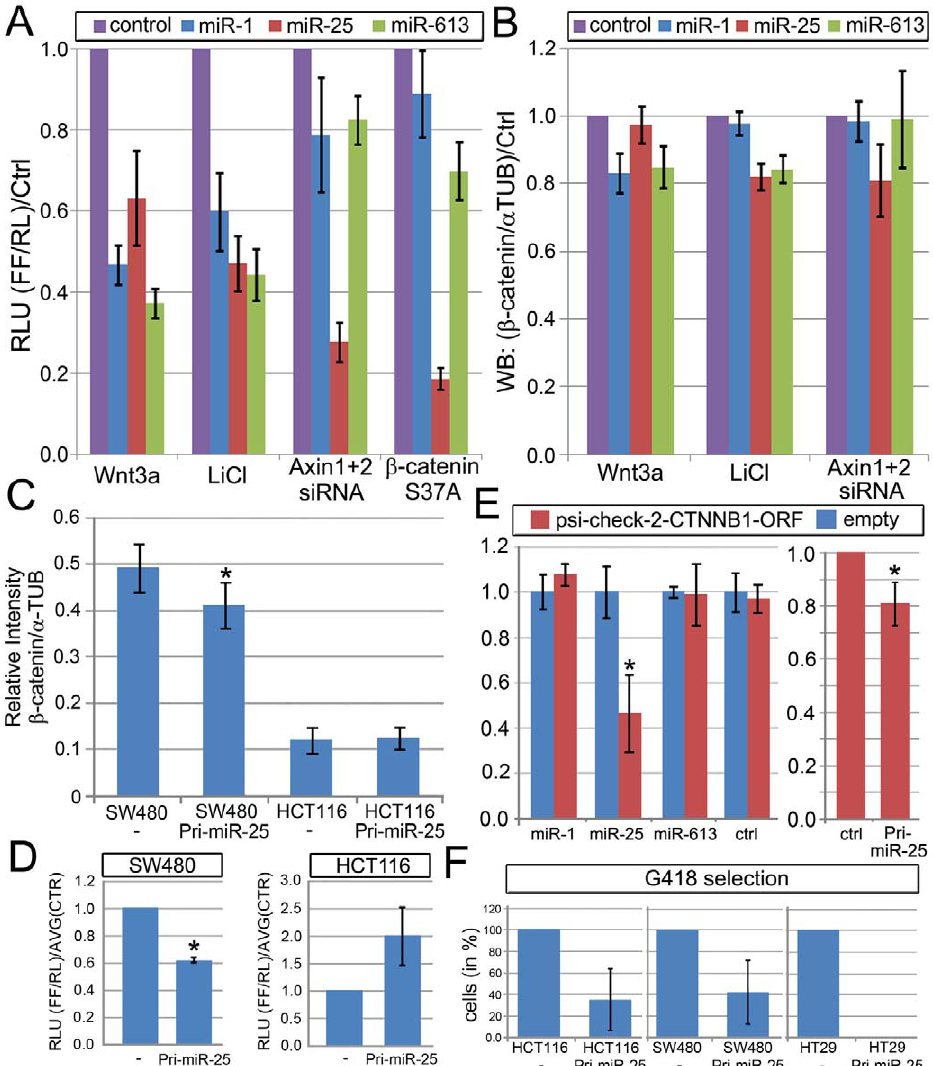
Figure 3. Molecular and functional characterization of candidate Wnt-regulatory miRs. (A) Epistasis experiments with synthetic human Pre-miR-1, Pre-miR-25 and Pre-miR-613. Influence of miRs on different epistatic pathway stimulations with Wnt3a, LiCl, Axin(1 + 2)-siRNA or S37A stabilized b -catenin that escapes default ubiquitination and degradation. (B) Semi-quantitative Western blotting to measure relative total b -catenin protein level changes ( b -catenin normalized with a -Tubulin level) in HEK293 cells transfected with 50 nM Pre-miR-1, Pre-miR-25 or Pre-miR-613 at day 3 using different pathway inductions (for 1 day) as indicated. (C) Semi-quantitative Western blotting measurement of relative total b -catenin protein level changes in SW480 colon cancer cell (APC deficiency). (D) STF19x reporter assay normalized by CMV/Renilla to measure endogenous pathway activity in Pri-miR-25 stable cancer cell lines (SW480, HCT116) compared to empty vector control stable cells. (E) Psi-check2 reporter assay system to measure the influence of b -catenin CDS mRNA fragment (inserted into the 3 9 UTR of a Renilla gene) on transcript translation in the presence of indicated miRs. Left: Blue columns represent the empty vector control. Red columns indicate the psi-check2-CTNNB1-CDS vector. Right: normalized psi-check2-CTNNB2 vector values are shown. (F) Viability of transfected cancer cells during G418 selection. Relative amount of cells obtained after the selection procedure to establish HCT116, SW480, and HT29 colorectal cancer cell lines expressing Pri-miR-25-pcDNA3.1(-)-Neomycin compared to empty vector control cells. Asterisk: unpaired student’s t-test, (P ,